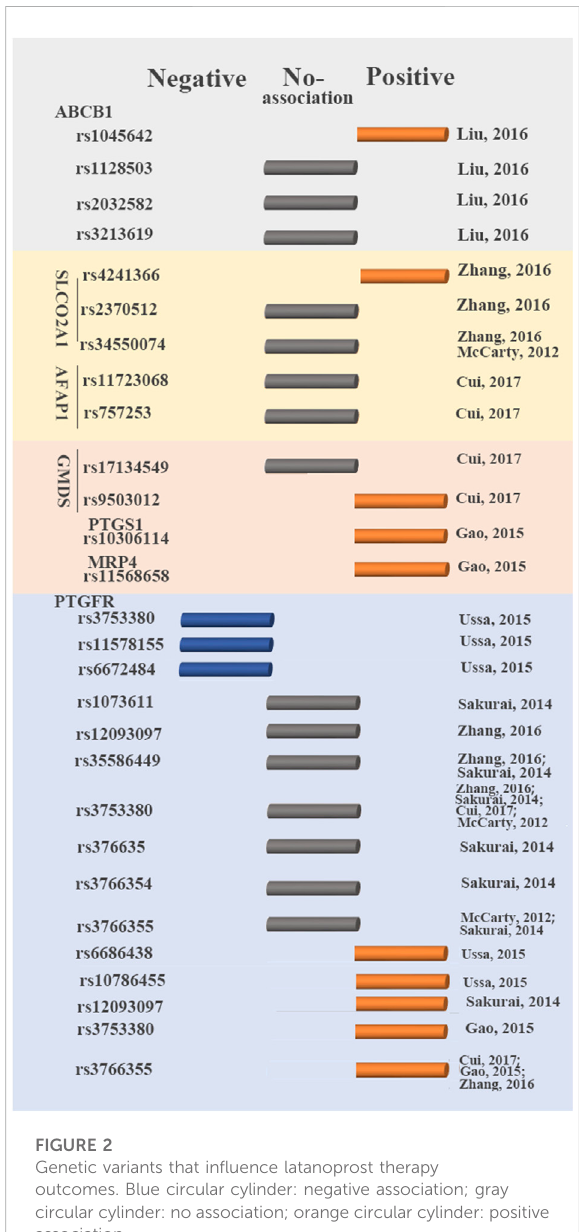
outcomes. Blue circular cylinder: negative association; gray circular cylinder: no association; orange circular cylinder: positive